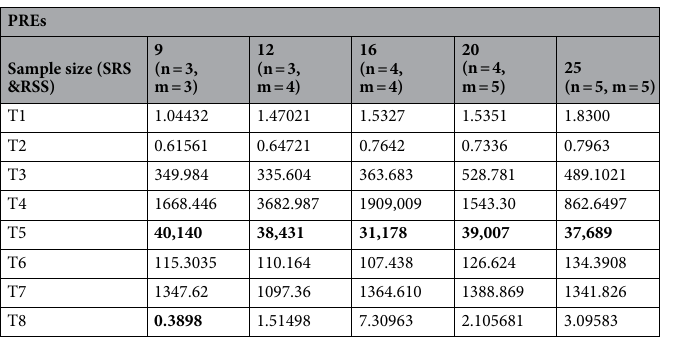
Table 4. Percent relative efficiencies (PREs) of estimators at rho = 0.51. Significant values are in bold.